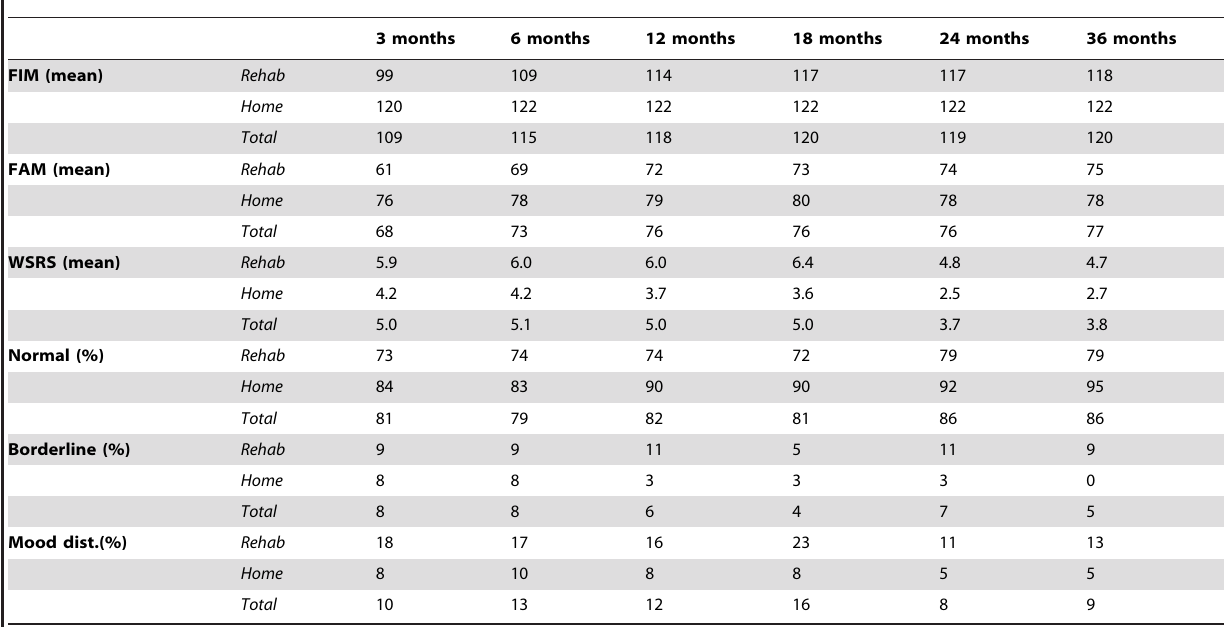
Table 2. FIM, FAM and WSRS outcomes at 3, 6, 12, 18, 24 and 36 months after